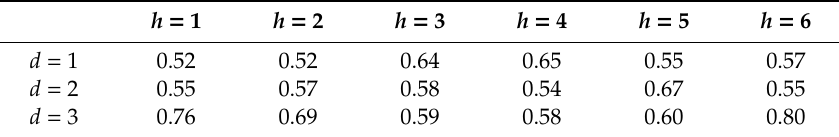
Table 12. Priority index of each hospital by each